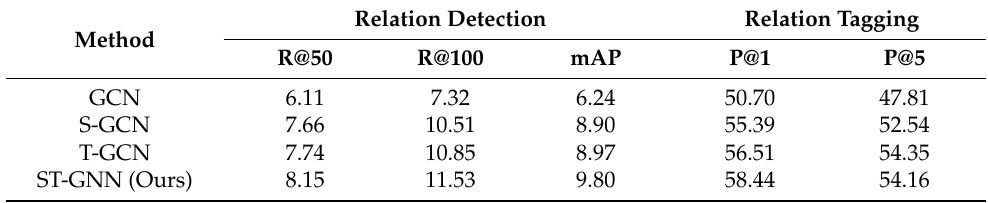
Table 4. Results of the CR method of different graph neural networks on VidOR validation